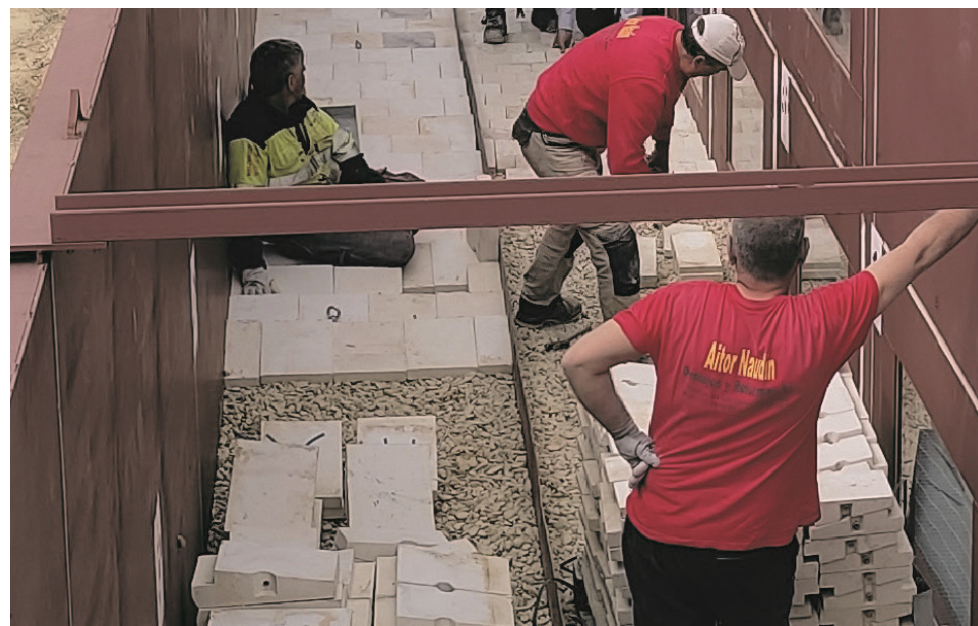
Figure 6. Picture of the placement of the WSB on the gravel bedding layer.